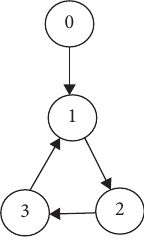
Figure 1: Digraph of the network topology.